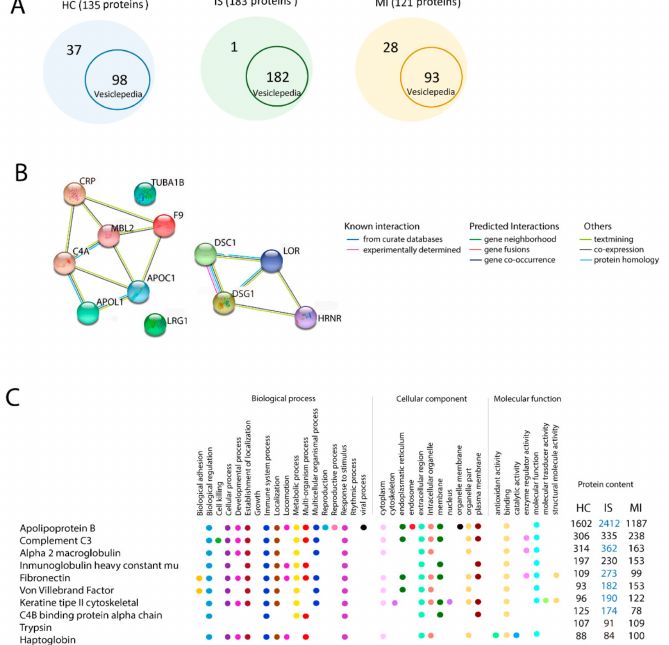
Figure 2. Proteomic analysis by mass spectrometry in extracellular vesicles. ( A ) Proteins identified in our experiments that have been previously found in the latest version of the human protein record in Vesiclepedia. ( B ) The 10 enriched proteins and their GO terms in the EV proteome from HC, IS, and MI. Comparison analysis for GO: biological process, cellular component and molecular function. Blue indicates whether the term is 2-fold more enriched in this group. ( C ) Interactions between the proteins identified in common for the IS and MI groups. Abbreviations: GO, gene ontology; HC, healthy controls; IS, ischaemic stroke; MI, myocardial